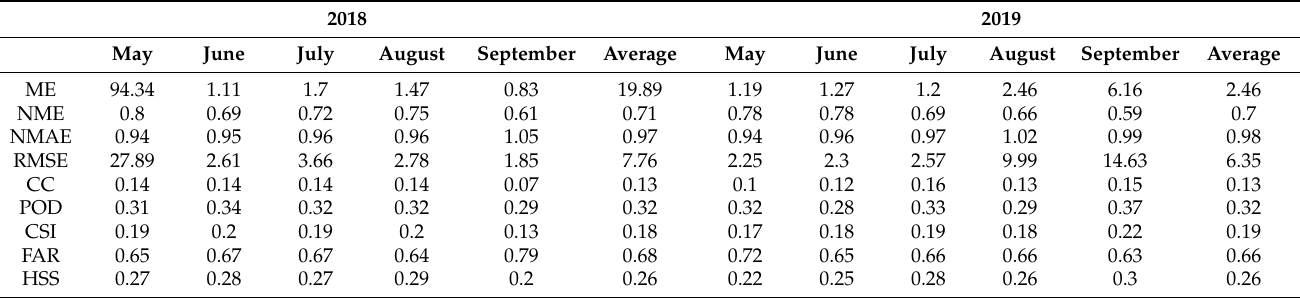
Table 7. Evaluation results of hourly rainfall accumulations